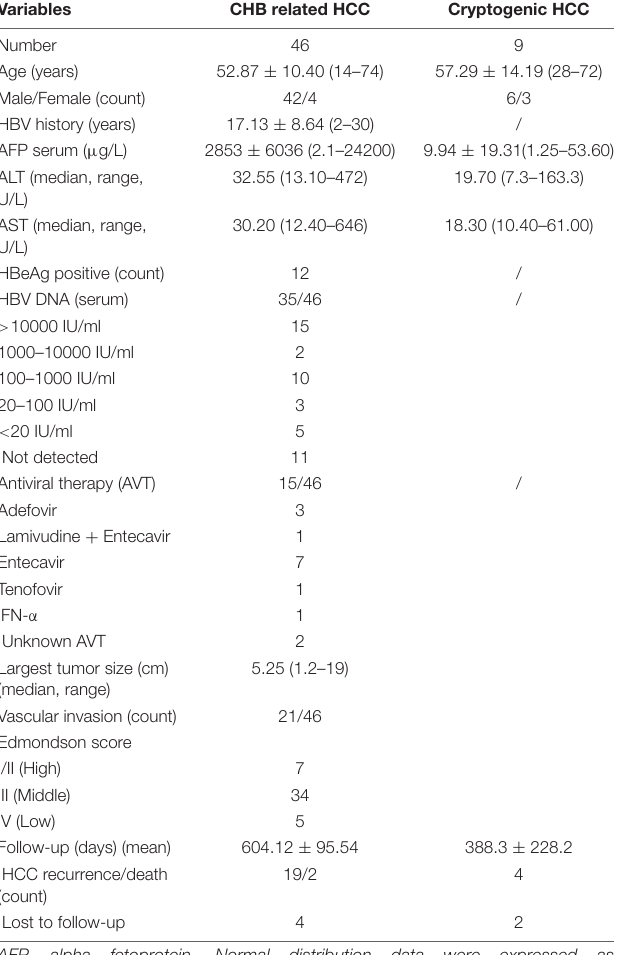
TABLE 1 | Baseline characteristics of 46 HBsAg-positive and 9 HBsAg-negative